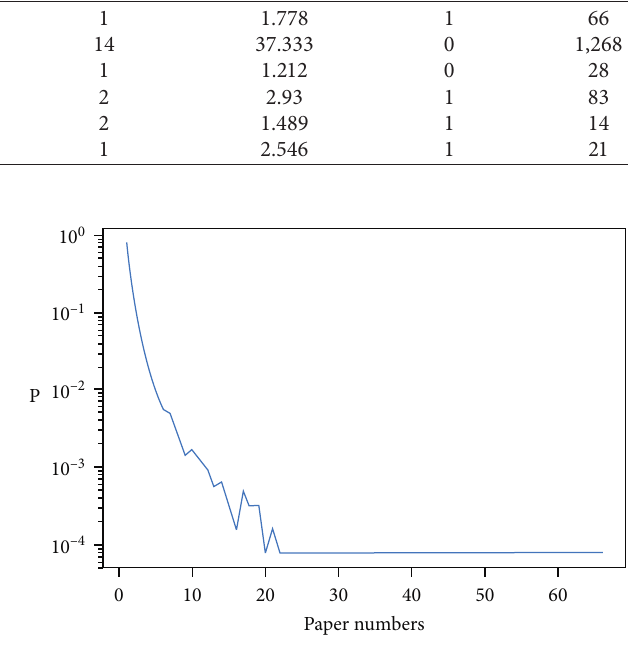
Figure 1: Distribution of the number of papers.